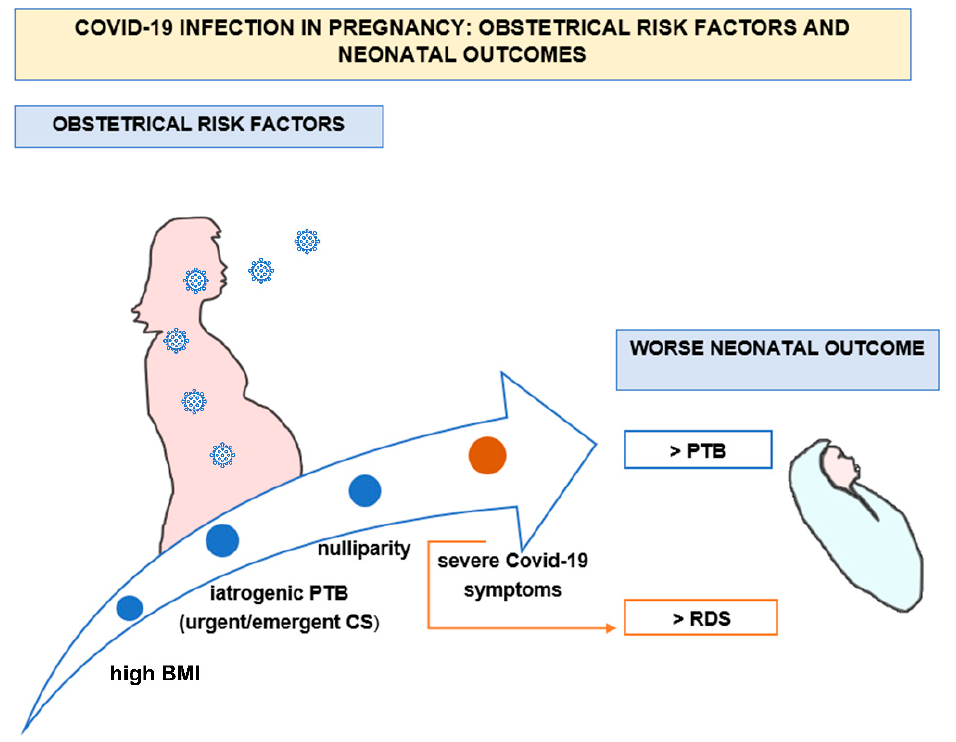
Figure 1. COVID-19 infection during pregnancy influences the neonatal outcome, increasing the rate of preterm birth (PTB) due to high BMI, iatrogenic causes of PTB requiring urgent or emergent cesarean section (CS), and the clinical pattern of severe maternal COVID-19 symptoms. In the last condition, there is also a higher risk of neonatal respiratory distress syndrome (RDS).